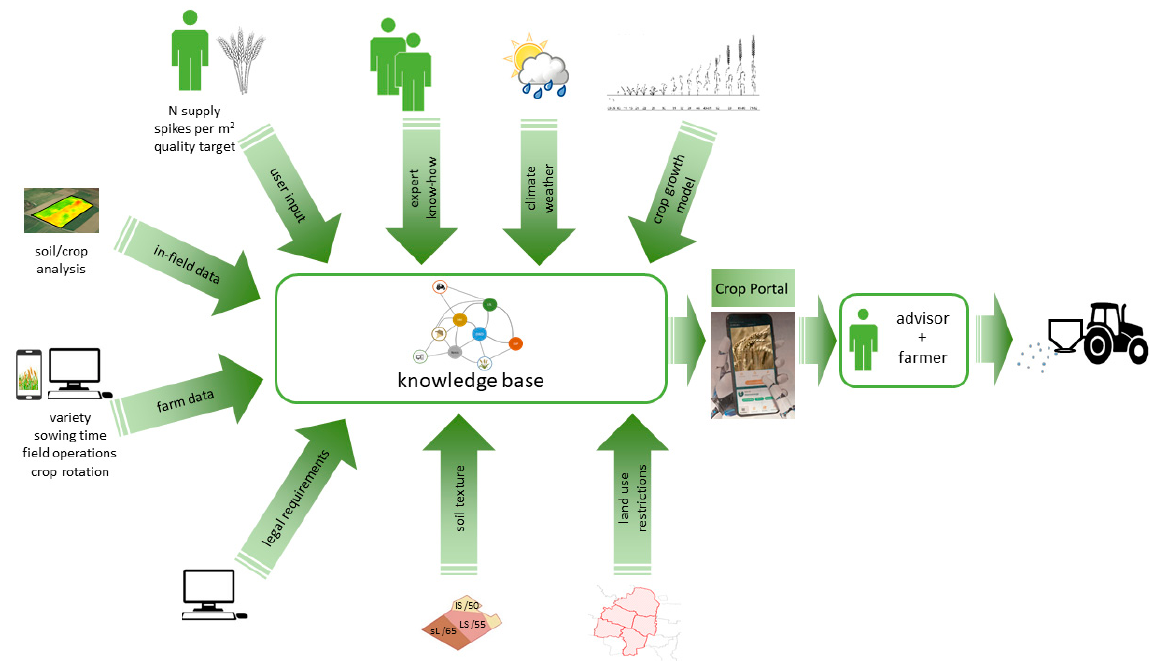
Figure 1. Relevant data for N fertilization decisions.